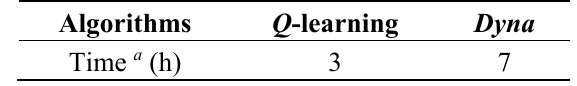
Table 3. Computation times of the Q -learning and Dyna